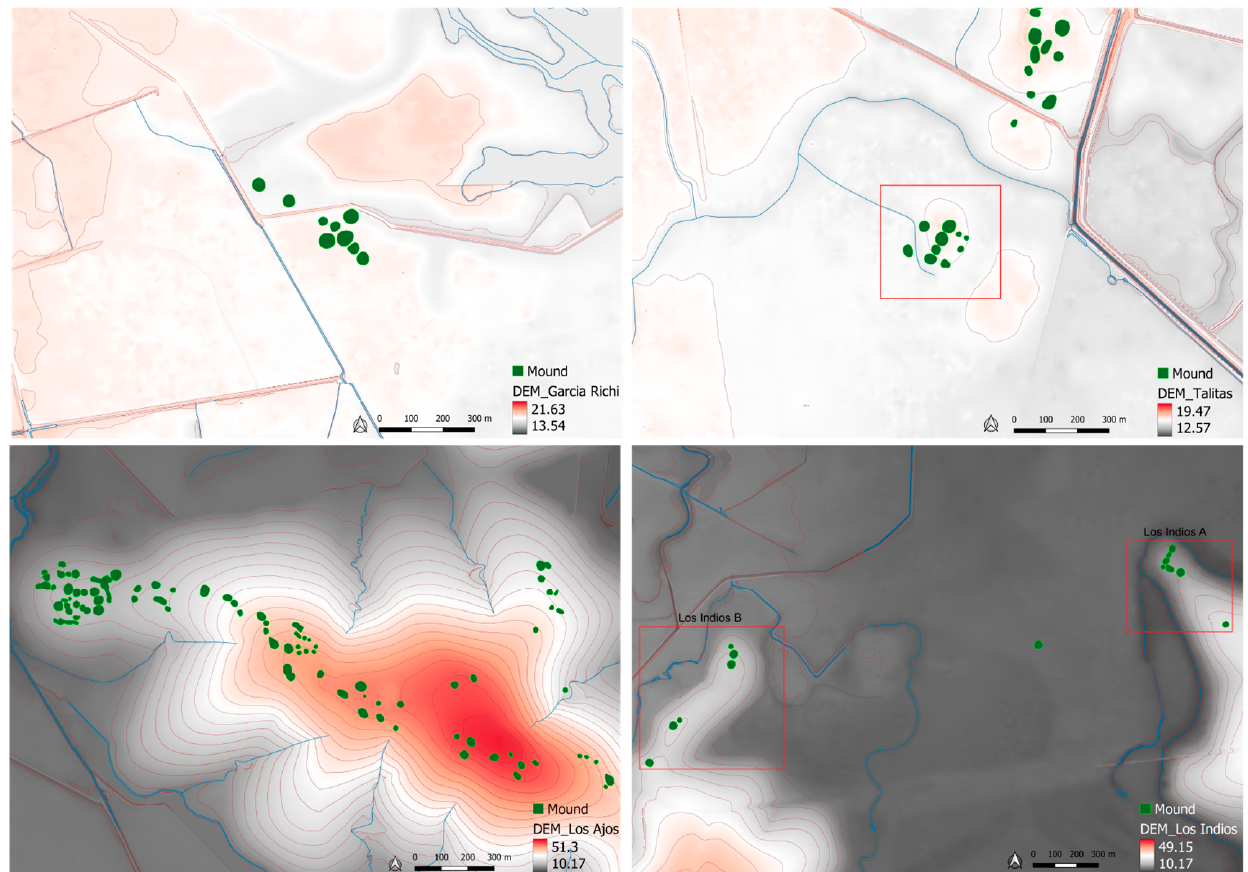
Figure 2. Digital elevation models (Infrastructure of Spatial Data from Uruguay) of archaeological sites with polygons of mounds. ( Top left ): Garcia Ricci mound site; ( Top right ): Talitas mound site; ( Bottom left ): Los Ajos mound site; ( Bottom right ): Los Indios mound sites A and B.